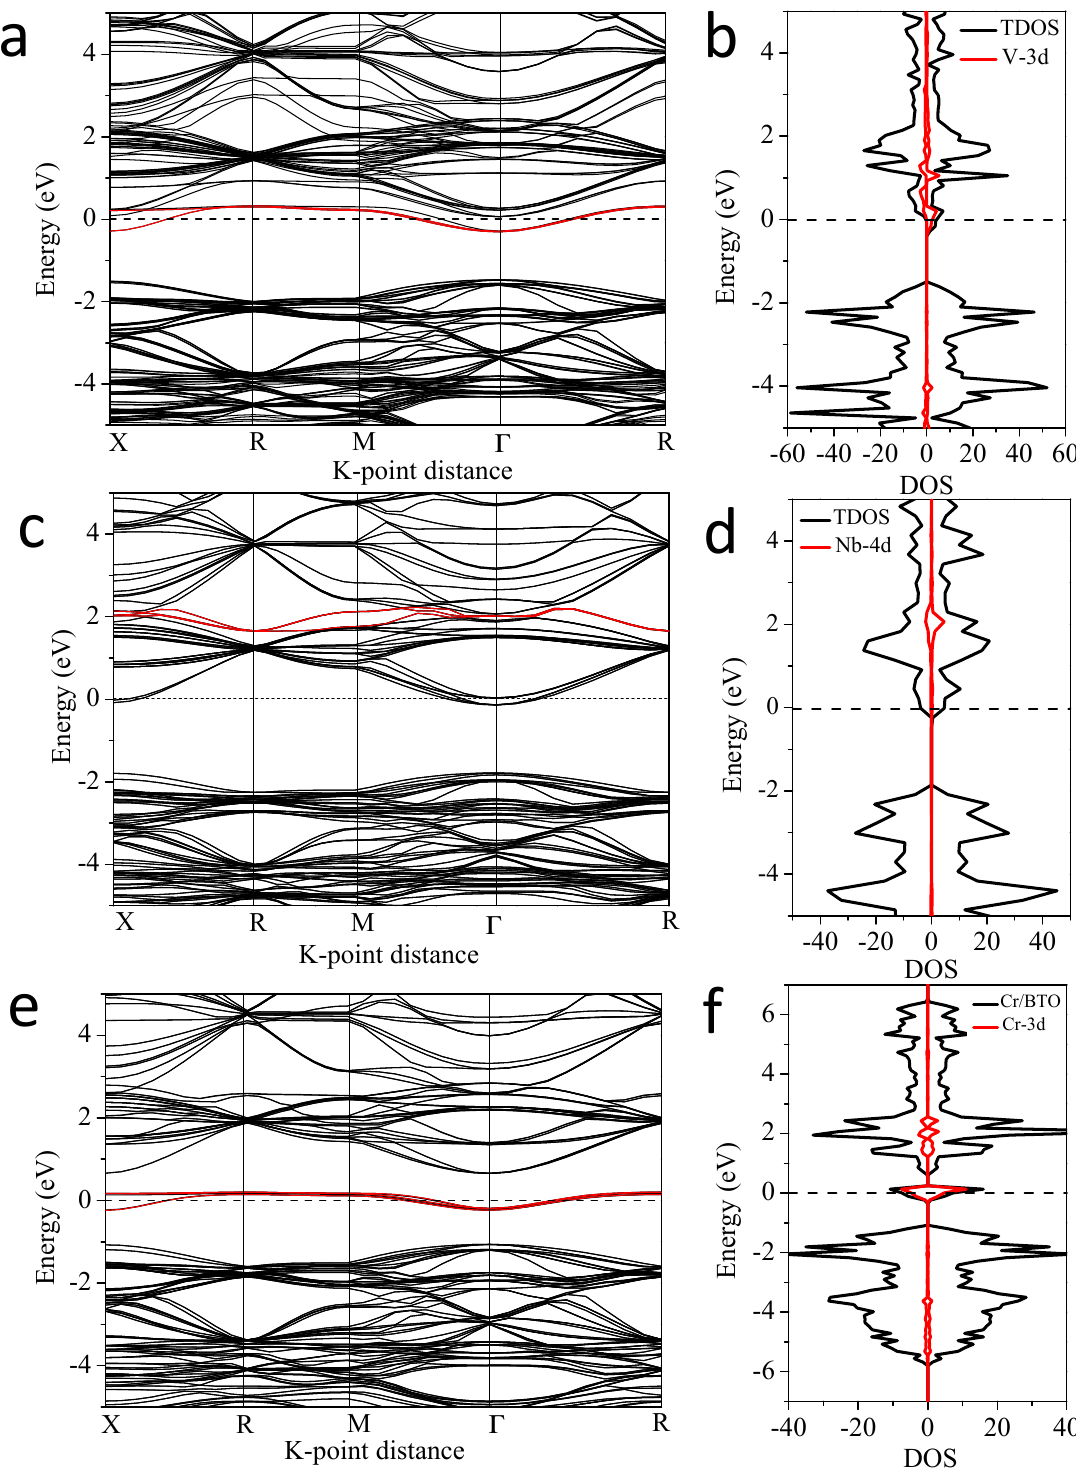
Figure 10. Band structures and total and partial density of states (DOS) of ( a , b ) Ba 8 Ti 7 VO 24 , ( c , d ) Ba 8 Ti 7 NbO 24 , and ( e , f ) Ba 8 Ti 7 CrO 24 .